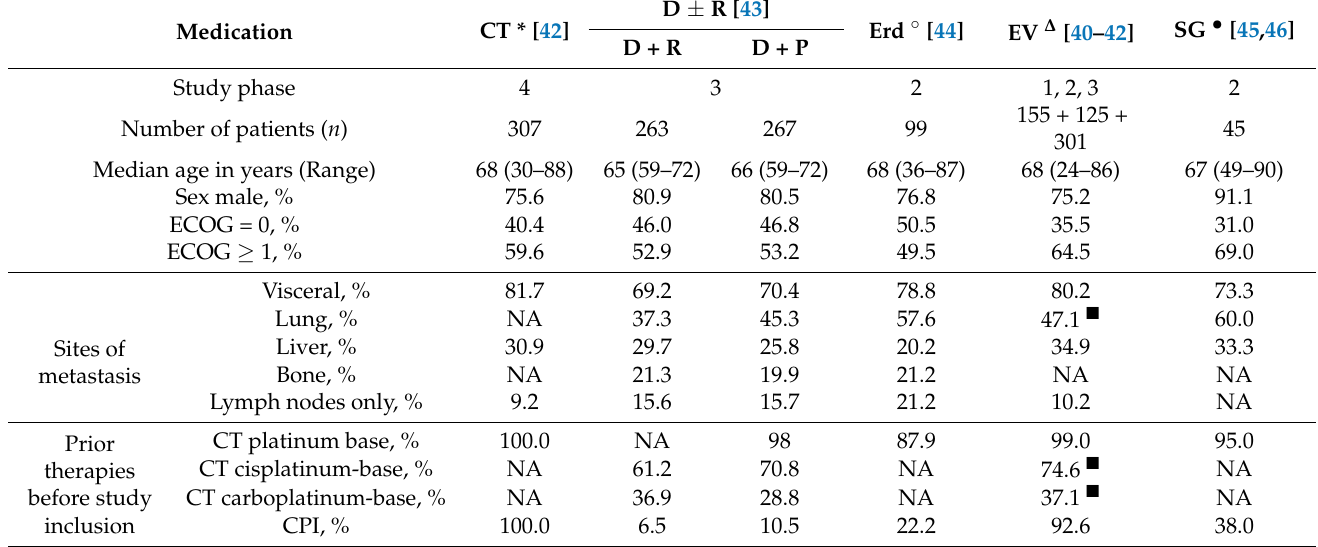
Table 1. * Paclitaxel, Docetaxel, Vinflunine. ◦ Selected regimen collective, treated with 8 mg of Erd continuously. ∆ Pooled data. (cid:110) Data only available for n = 155 [40] + 125 [41]. • Bladder cancer subgroup, treated with 10 mg SG/kg of body